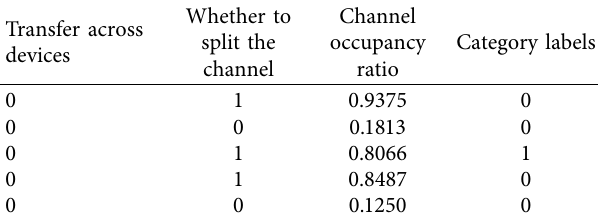
Table 1: Example of topology impact samples.